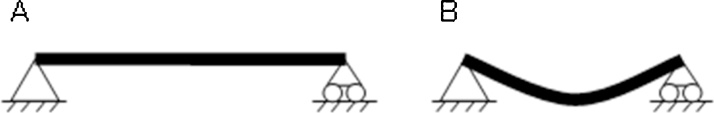
(A) flat stationary plate, (B) bent plate due to vibration.